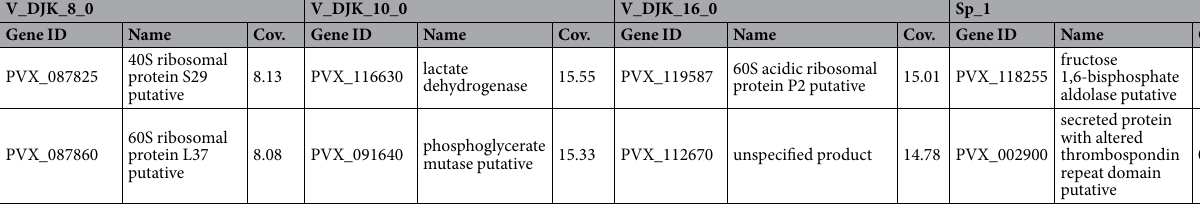
Figure 5). One example of isoforms generated by variation in UTR length is the Multi-Drug Resistance gene 1 (PvMDR1, PVX_080100), also a candidate marker for chloroquine resistance, for which some transcripts (encod- ing an identical amino acid sequence) displayed splicing of an unannotated 3 ′ -UTR intron, resulting in a longer UTR (Fig. 2B).